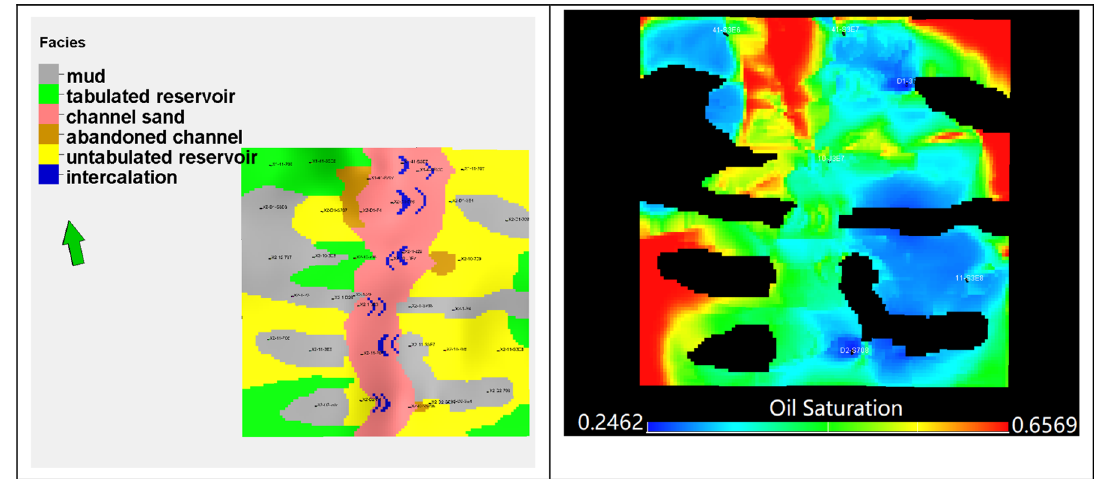
Fig. 10 The map of facies model and oil saturation simulation result in study area. a Facies mode set in study area; b oil saturation simulation result set in study